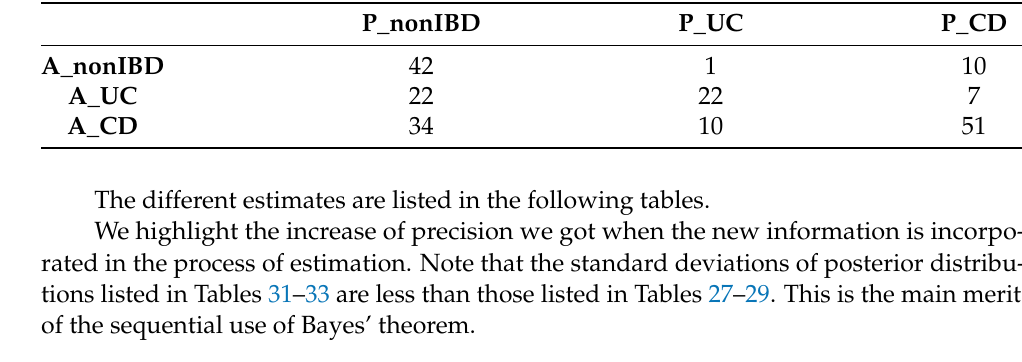
Table 31. Bayesian summaries Step 2 in A_nonIBD